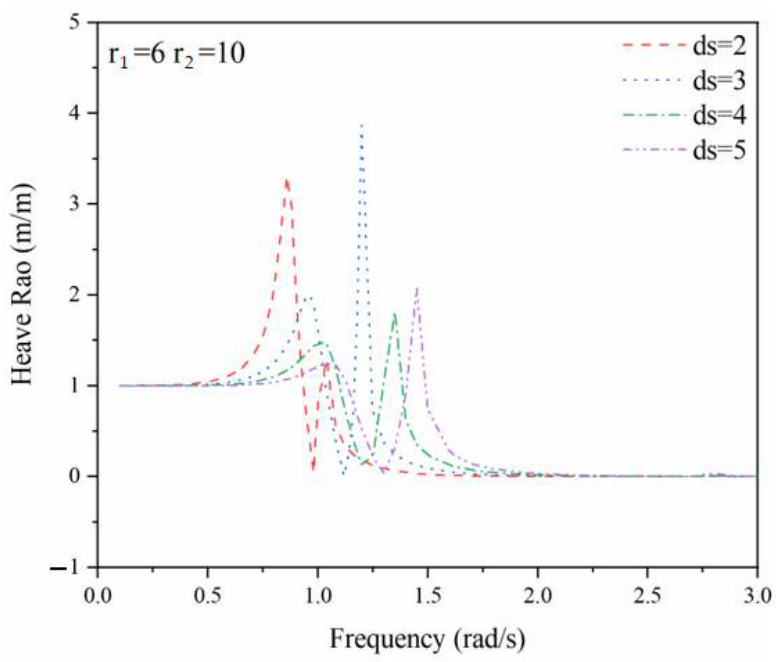
Figure 8. Heave RAOs under different ds cases.